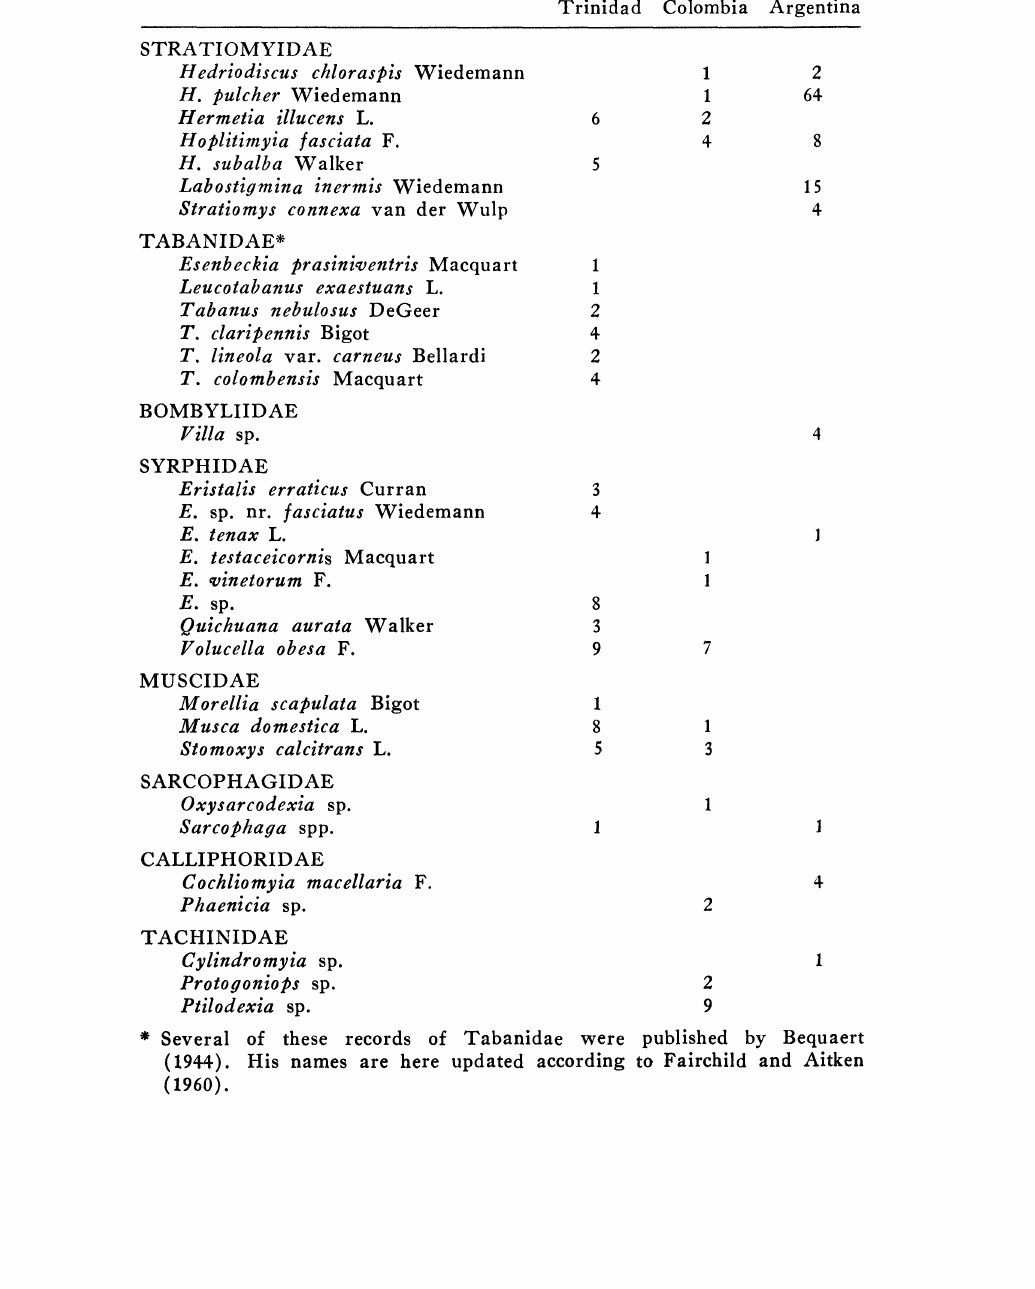
Table 2. Dipterous records for Rubrica surinamensis Species oi: